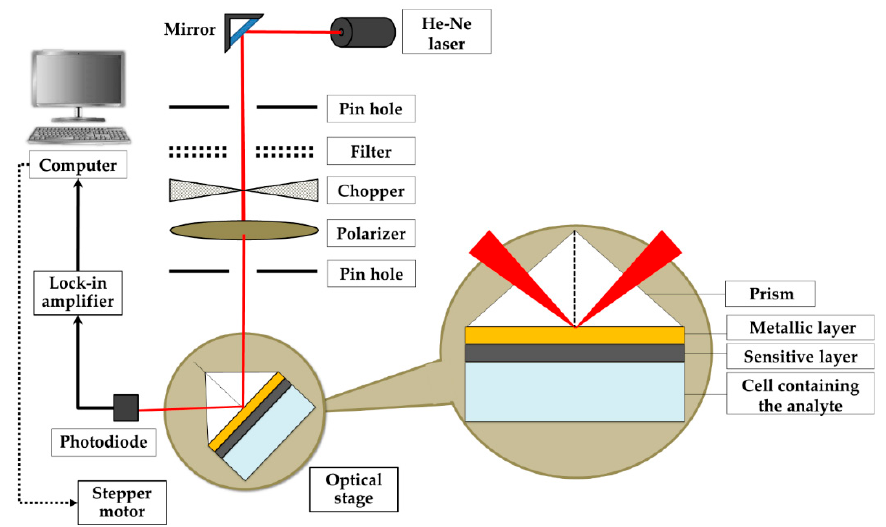
Figure 1. Experimental setup for exploring plasmonic sensing of the NCC/PEDOT thin film.